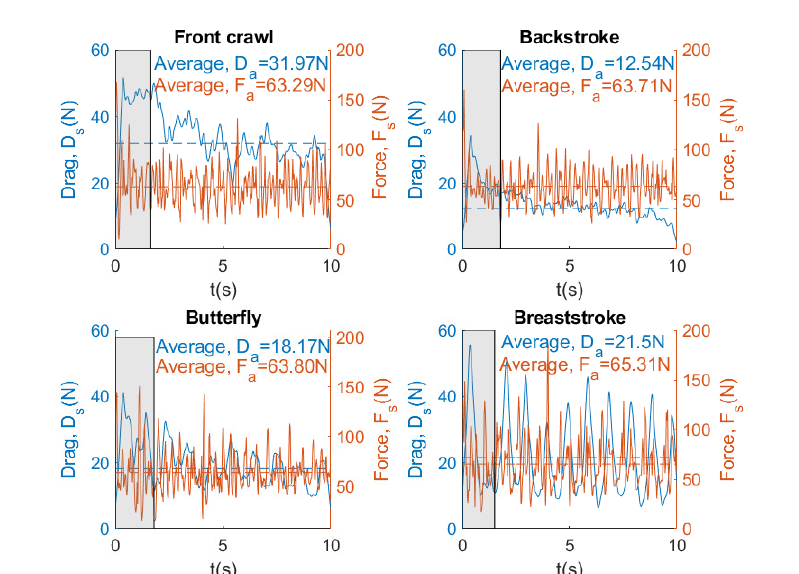
Figure 15. Instantaneous and average force and drag for four swimming strokes. Brake force = 68.41 N.